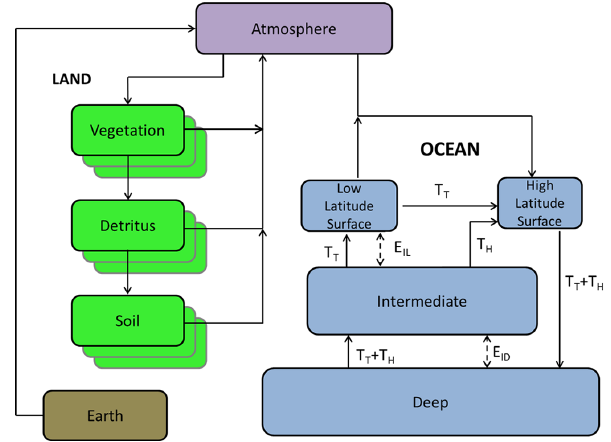
Figure 2. Representation of Hector’s carbon cycle, land, atmo- sphere, and ocean. The atmosphere consists of one well-mixed box. The ocean consists of four boxes, with advection and water mass exchange simulating thermohaline circulation (see Table 2 for de- scription of parameters). At steady state, the high-latitude surface ocean takes up carbon from the atmosphere, while the low-latitude surface ocean off-gases carbon to the atmosphere. The land consists of a user-defined number of biomes or regions for vegetation, detri- tus and soil. At steady state the vegetation takes up carbon from the atmosphere while the detritus and soil release carbon back into the atmosphere. The earth pool is continually debited with each time step to act as a mass balance check on the carbon